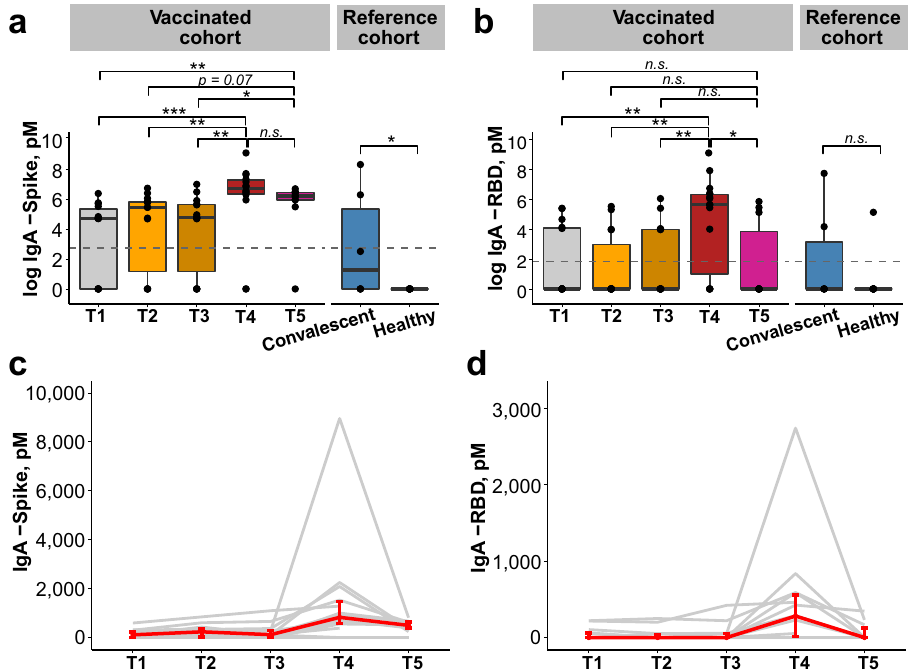
Fig. 1 SARS-CoV-2-speci fi c IgA antibodies in human milk samples. Concentration [pM a ] of IgA antibodies against spike ( a ) and RBD ( b ) in human milk for vaccinated women ( n = 14) across T1 – T4, ( n = 10) at T5; convalescent ( n = 6) and healthy women ( n = 9) used as reference cohort. Gray dotted lines re fl ect the limit of assay detection. p values were calculated with Kruskal – Wallis test and Dunn ’ s post hoc test, * p < 0.05, ** p < 0.01, *** p < 0.001, n.s. non-signi fi cant. Box and whiskers plots show median (center line), interquartile range (box), and 10th and 90th percentiles (whiskers). Increase in IgA antibodies against spike ( c ) and RBD ( d ) over time. Line plots show the median, and error bars show the fi rst and third quartiles. Each line in gray represents data from one individual and the median ± IQR is represented in red. RBD receptor- binding domain, IgA immunoglobulin A, pM picomolar, IQR interquartile range, T1 pre-vaccination, T2 1 – 3 days after dose 1 of BNT162b2 vaccine, T3 7 – 10 days after dose 1 of BNT162b2 vaccine, T4 3 – 7 days after dose 2 of BNT162b2 vaccine, T5 4 – 6 weeks after dose 2 of BNT162b2 vaccine. a SI conversion factors: to convert concentration from pM to M, multiply values by 10 12